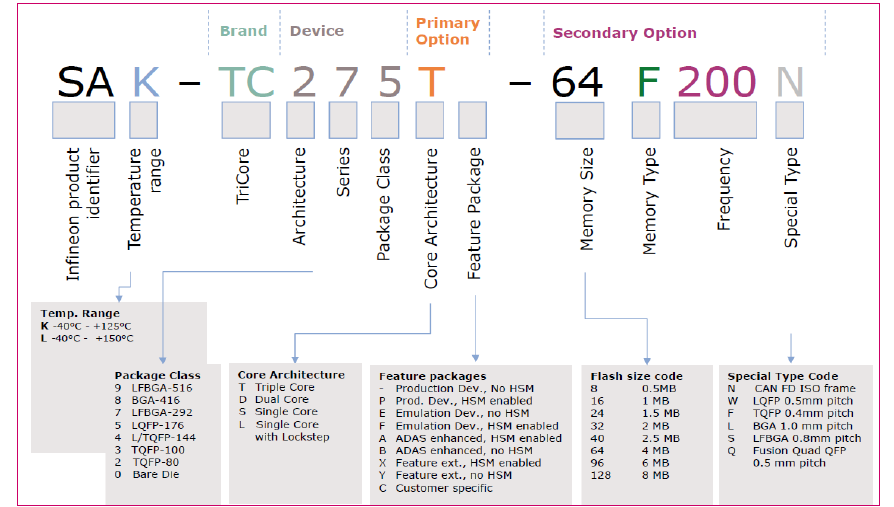
Figure 3. Microcontroller (AURIX Infineon) component nomenclature. Reproduced from [4].